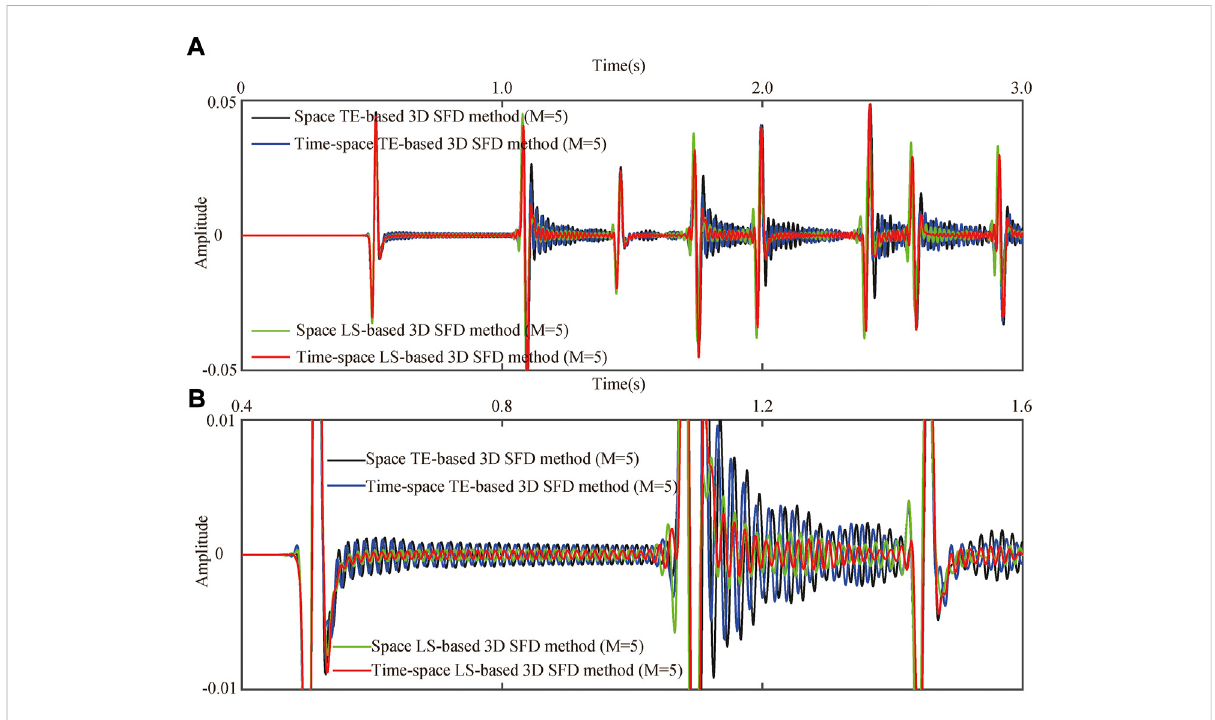
FIGURE 8 Vibration curves simulated by different 3D SFD methods ( M (cid:2) 5) for the simple 3D homogeneous acoustic model (Model B) at particle ( x , y , z ) (cid:2) ( 1 . 0km , 1 . 0km , 2 . 0km ) . (A) Full vibration curves. (B) Local magni fi cation curves.